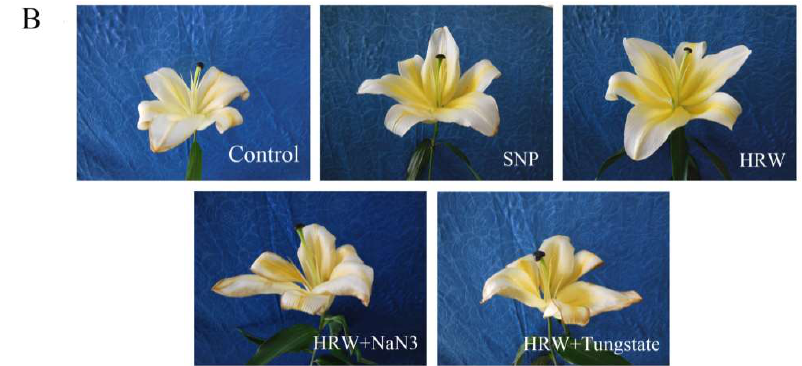
Figure 1. Effects of hydrogen-rich water (HRW), sodium nitroprusside (SNP), and HRW plus NaN 3 or tungstate on the vase life of cut lily flowers. The cut flowers were placed randomly in distilled water (control), 150 µ M SNP, 1% HRW, 1% HRW + 50 µ M NaN 3 and 1% HRW + 100 µ M tungstate to investigate. The values of vase life ( A ) are the mean ± SE of three independent experiments. Bars with different letters illustrate significant differences ( p < 0.05) according to Duncan’s multiple range test. Photos ( B ) were taken after 8 days of treatments.